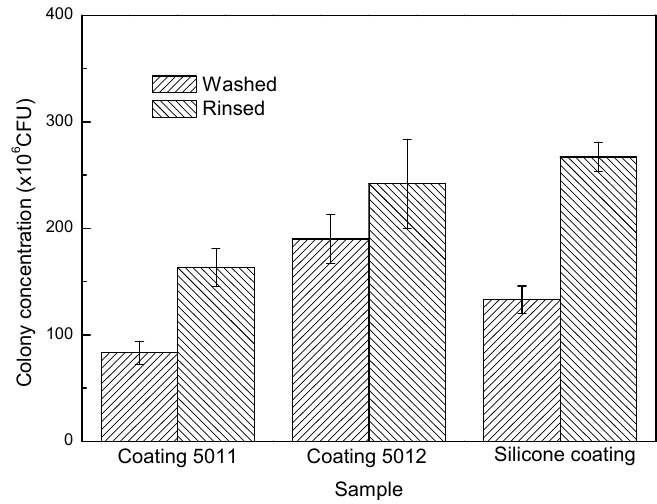
Figure 10. Concentration of bacterial colonies in test samples.